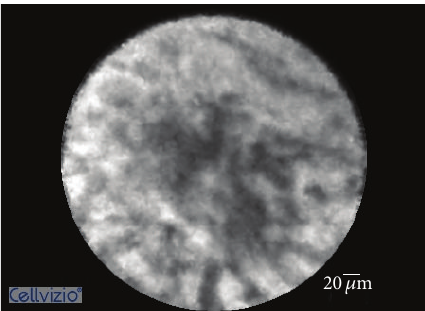
Figure 2: Probe-based confocal laser endomicroscopy imaging showing dark granular pattern with scales.